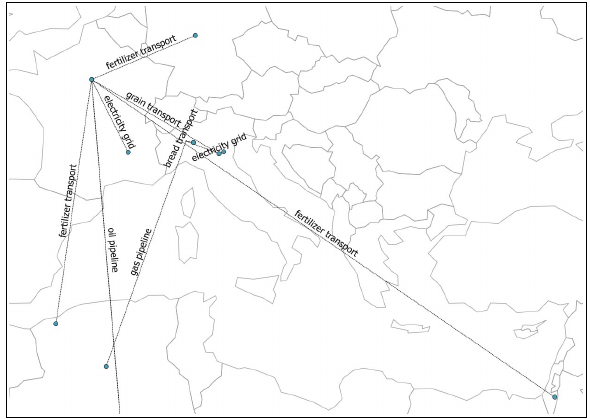
Figure 4. Connections (lines) mapped in an IG of a bread supply chain, average italian practice